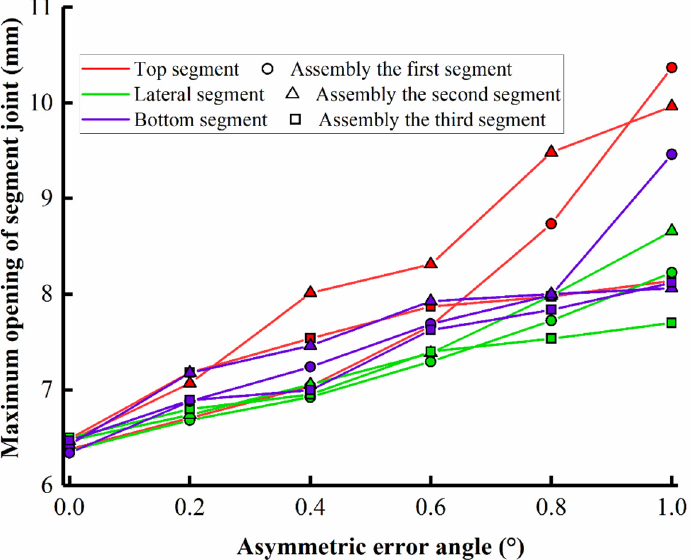
Figure 15. Maximum opening of segment joints in the presence of inward deflection.